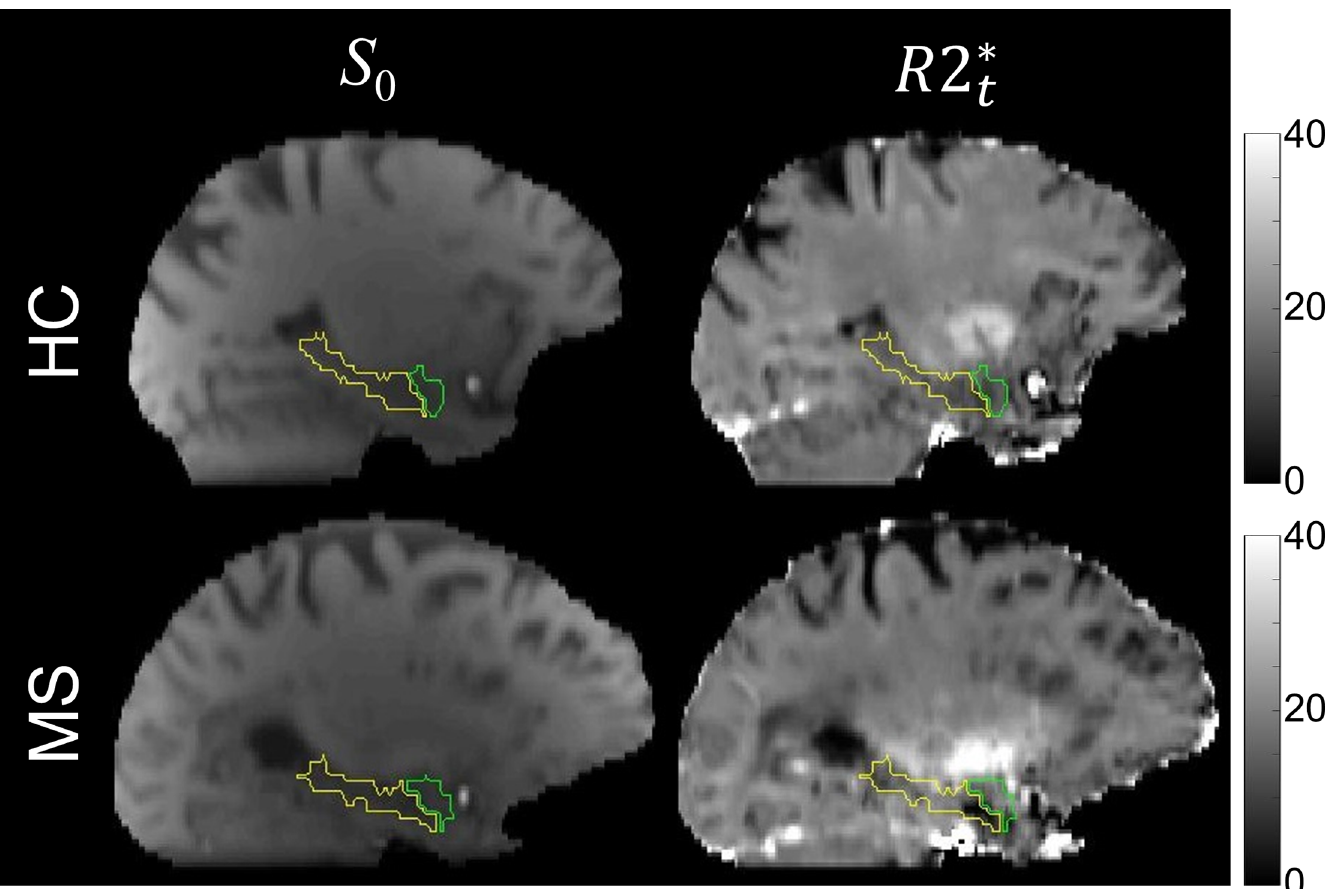
Fig 1. Examples of GEPCI S 0 (T1w) images and R2t * maps selectedfrom a healthy control (HC: 58 yr old, female) and MS patient (MS: 60 yr old, female). Hippocampusand amygdalaregions are marked by yellow and green contours, respectively.Despite no dramatic volumetricchangesbetween HC and MS in these two structures, the MS patient showedsignificantlower R2t * in the anterior hippocampus region.